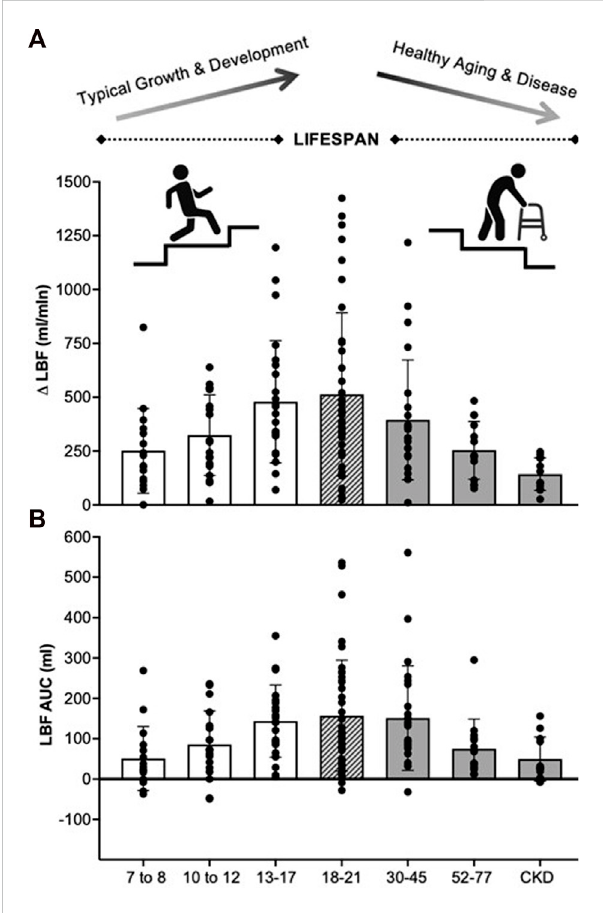
FIGURE 1 Absolute change in leg blood fl ow (A) and leg blood fl ow area underthecurve (B) responses toPLM for various ageandhealthstatus groups recently collected in our laboratory. 7 – 8 years ( n = 16, M/F: 9/ 7), 10 – 12 years ( n = 19, M/F: 11/8), 13 – 17 years ( n = 24, M/F: 12/ 12), 18 – 21 years ( n = 40, M/F: 14/26), 30 – 45 years ( n = 24, M/F: 8/16), 52 – 77 years ( n = 14, M/F: 5/9), CKD ( n = 12, M/F: 7/5). For illustrative purposes only. LBF, leg blood fl ow; Δ , absolute change; AUC, area under the curve, CKD, chronic kidney